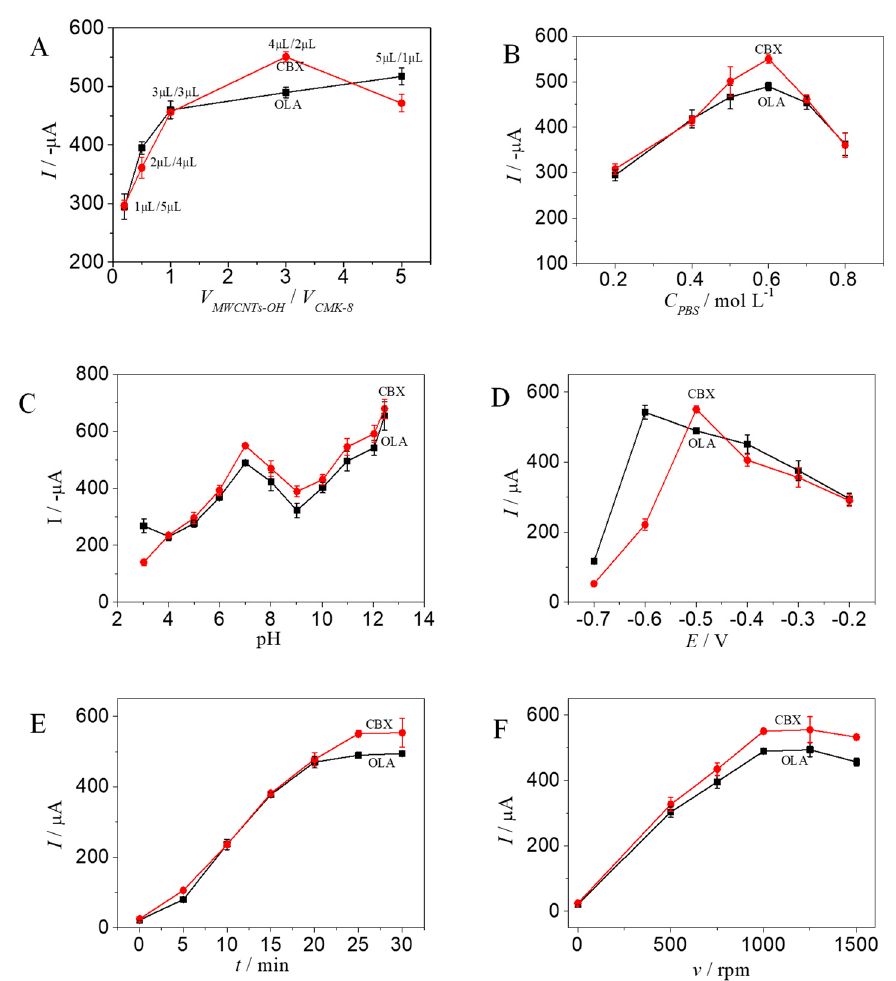
Figure 5. Optimization of the experiment factors ( A : the volume ratio of MWCNTs − OH and CMK − 8, B : PBS concentration, C : pH, D : enrichment potential, E : enrichment time, and F : stirring speed).